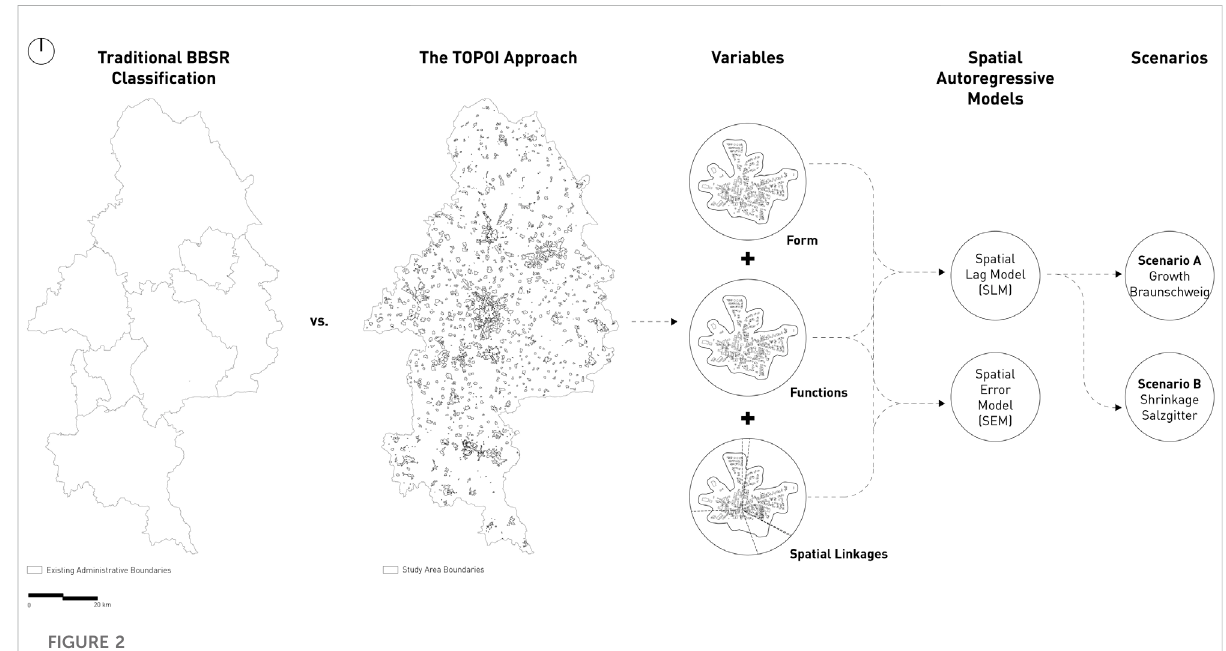
FIGURE 2 Flowchart explaining the research methods used in the study.